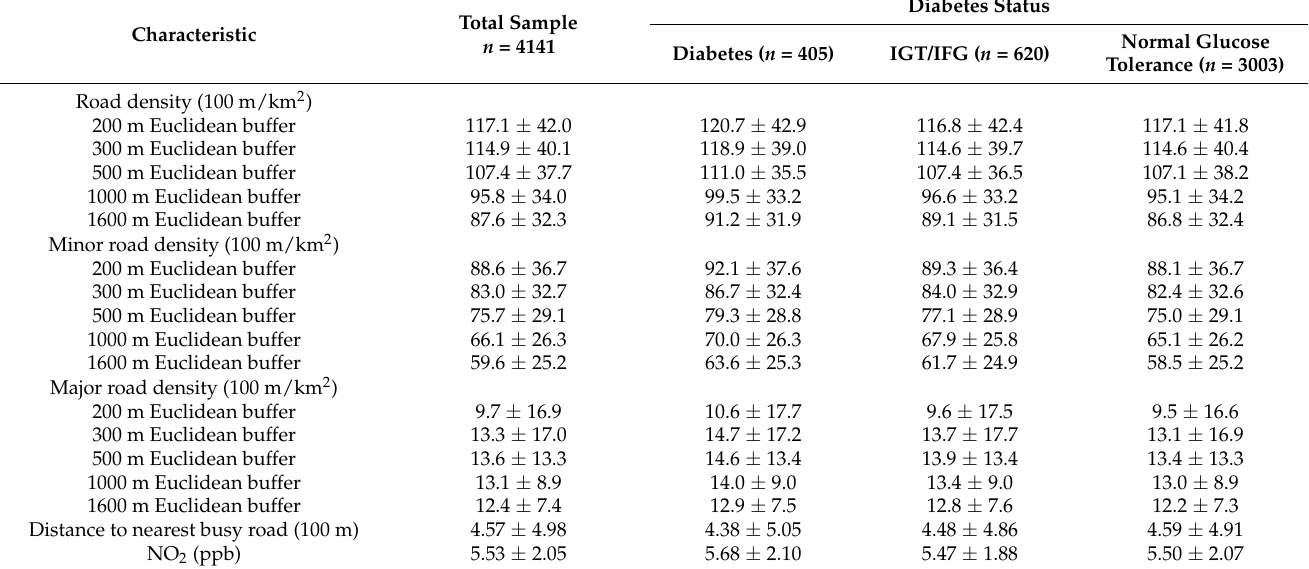
Table 2. Descriptive statistics of traffic-related air-pollution measures (M ±